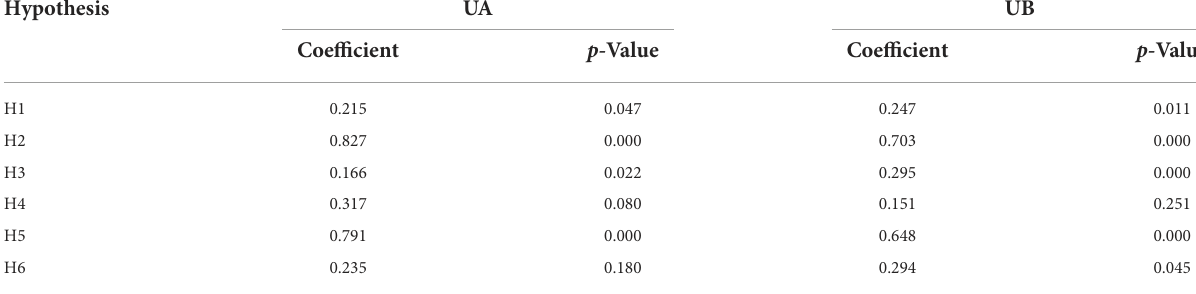
TABLE 6 Results of the structural